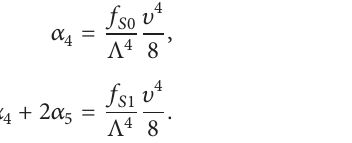
the best limits are obtained for the 𝑃 𝑒 − = −80 %; 𝑃 𝑒 + = 60 % polarization state.